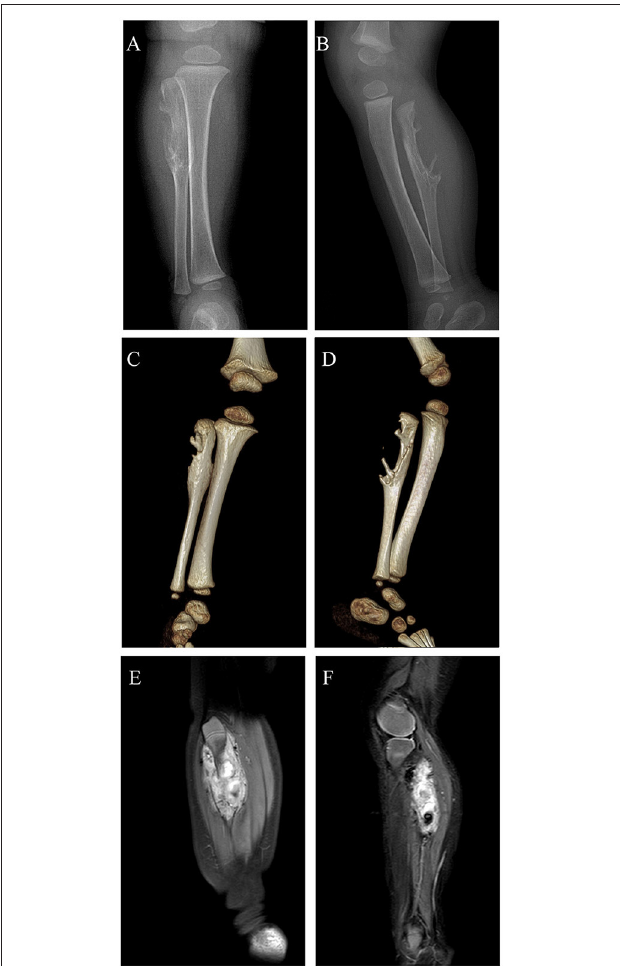
FIGURE 1 | Digital radiograph preoperatively: (A,B) Radiographs of the right tibia and fibula showing an irregular bone destruction of proximal fibula; (C,D) 3d CT reconstruction demonstrating lytic bone destruction of right proximal fibula; (E,F) MRI revealing a massive vascular tumor with surrounding soft tissue hyperplasia and involvement of the proximal fibular epiphyseal plate.